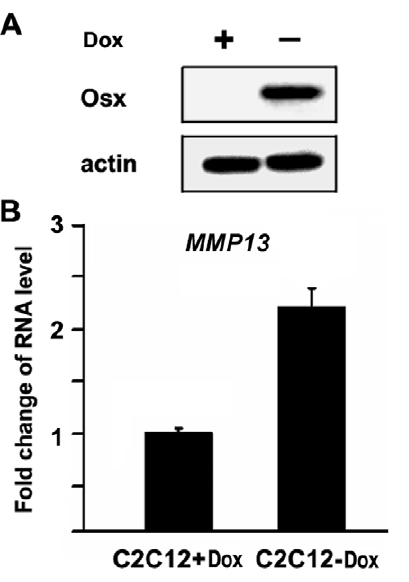
Figure 3. siRNA-directed knockdown of Osx impairs MMP13 gene expression in MC3T3 osteoblasts. RNA expression levels were determined by quantitative real-time RT-PCR. MC3T3 osteoblasts were transfected with siRNA targeting mouse Osx. RNA was isolated 24 hr post-transfection and quantitated by real-time RT-PCR. The RNA level from the control siRNA group was normalized to a value of 1. Values were presented as the mean 6 S.D. si-C: Lamin A/C Control siRNA as a non-specific control; si-Hif1a: siRNA against Hif1a as another control; si-Osx: si-RNA against Osx.